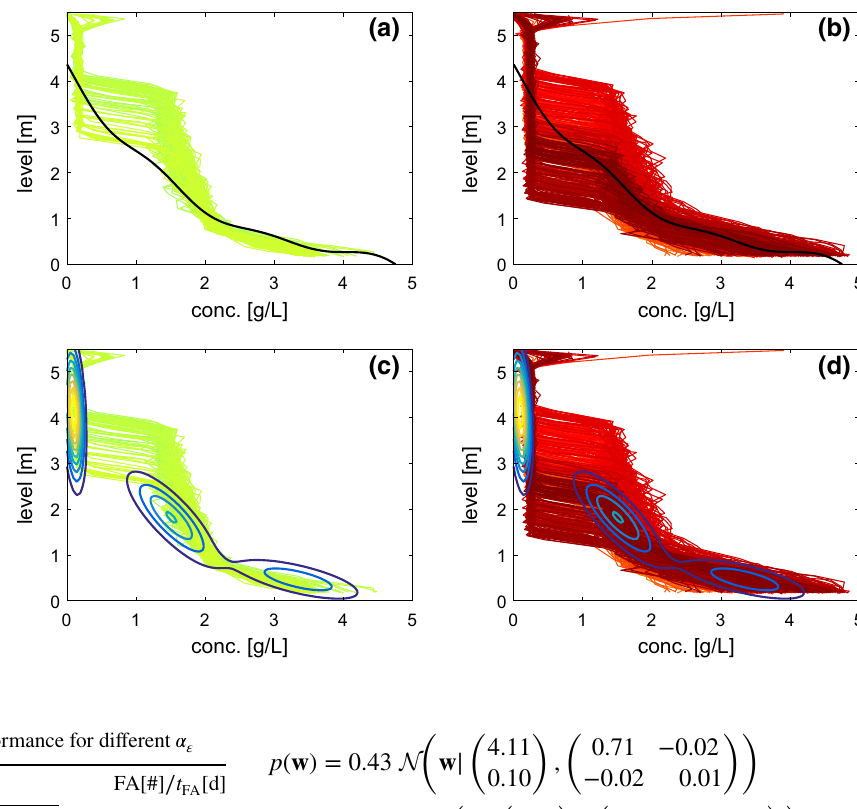
Fig. 5 Group of sludge profiles for periods indicated in Fig. 4a. For GPR: a Period A, b Period B. The plots include the predic- tive mean of the training data set (black line). For GMM: c Period A, d Period B. The plots include the contours of the probability density function of the training data set